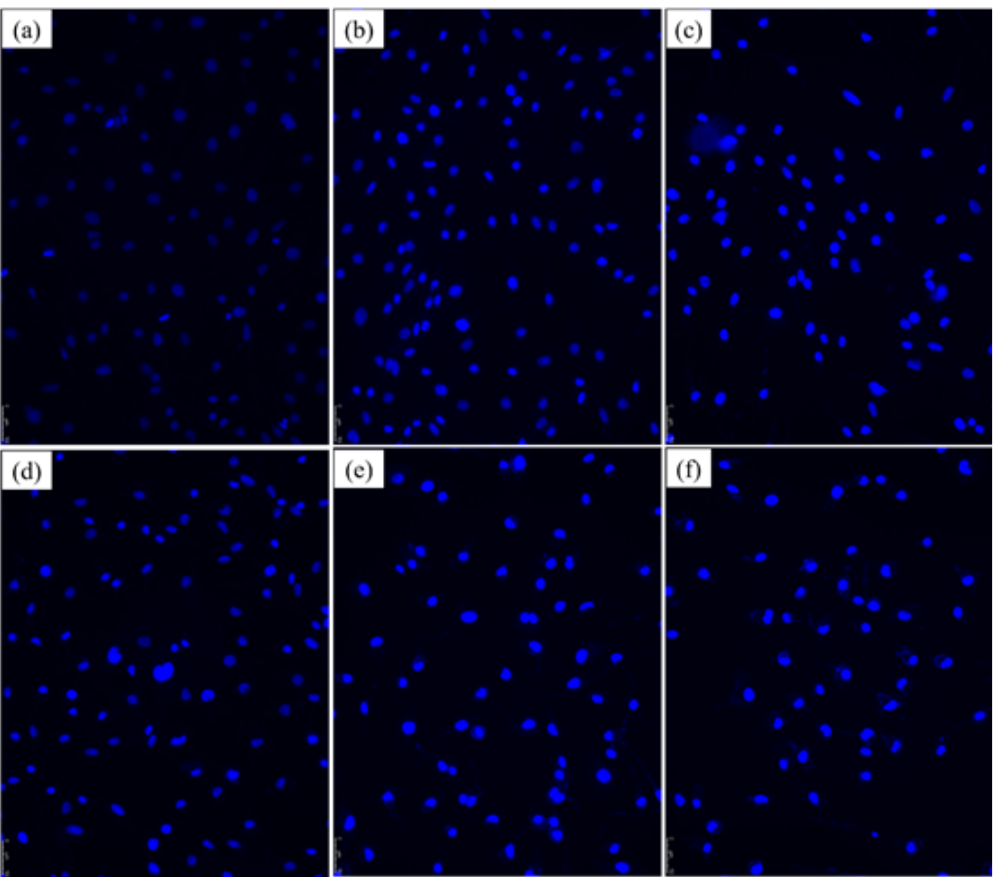
Figure 2: Immunocytochemical detection of METH induced apoptosis in U-118 MG cells. Hoechst 33258 staining indicated that METH induced U-118 MG cells apoptosis. Morphologic changes in nuclei were observed with Hoechst 33258 staining under fluorescence microscopy. (a) Control group. The cells were shaped normally and had round, intact nuclei; (b) METH 198 μg/mL group; (c) METH 296 μg/mL group; (d) METH 444 μg/mL group; (e) METH 667 μg/mL group group; (f) METH 1000 μg/mL group. Original magnification is